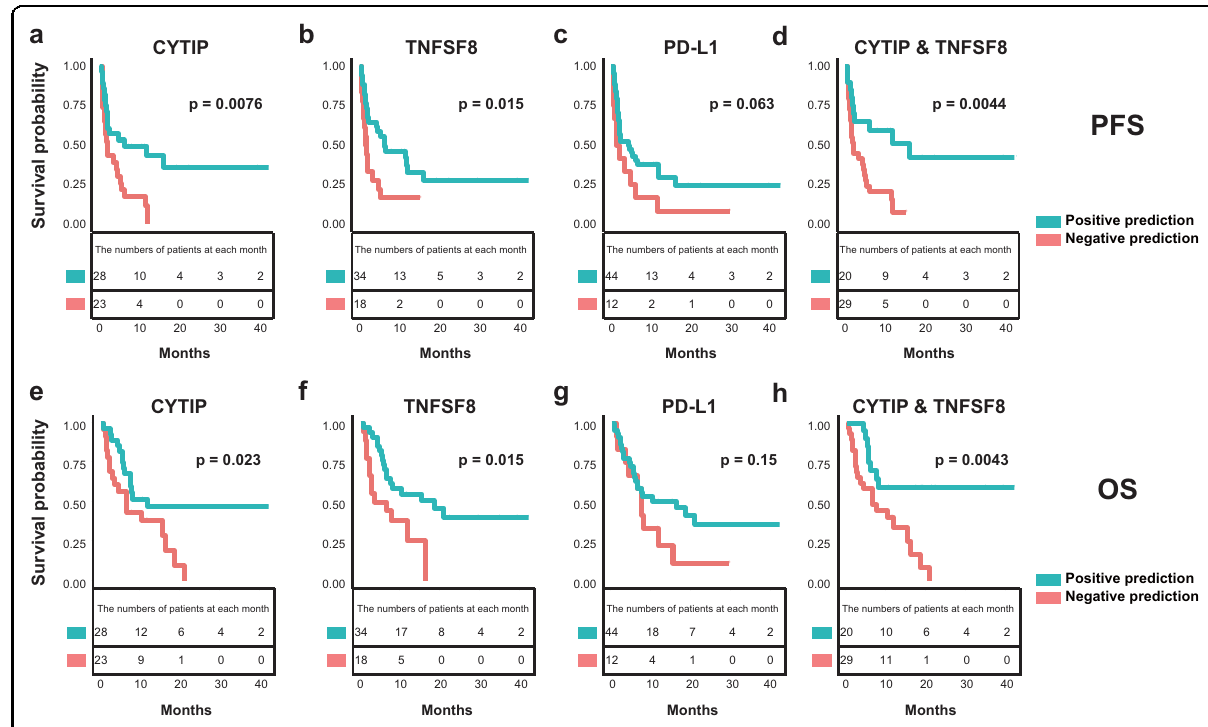
Fig. 5 Evaluation of pDMRs for CYTIP and TNFSF8 to predict survival after anti-PD-1 therapy. a – d Comparison of progression-free survival (PFS) between the patients ’ group based on the methylation level of pDMR for CYTIP (methylation of CYTIP promoter ≤ 40% vs. > 40%) a , methylation level of pDMR for TNFSF8 (methylation of TNFSF8 promoter ≤ 50% vs. > 50%) b , PD-L1 expression (PD-L1 ≥ 1% vs. < 1%) c , or combined use of both pDMRs (methylation of CYTIP ≤ 40% and TNFSF8 ≤ 50% promoter vs. the others) d . e – h Comparison of overall survival (OS) between the patients ’ group based on the methylation level of the pDMR for CYTIP (methylation of CYTIP promoter ≤ 40% vs. > 40%) e , the methylation level of the pDMR for TNFSF8 (methylation of TNFSF8 promoter ≤ 50% vs. > 50%) f , PD-L1 expression (PD-L1 ≥ 1% vs. < 1%) g , or combined use of both pDMRs (methylation of CYTIP ≤ 40% and TNFSF8 ≤ 50% promoter vs. the others) h